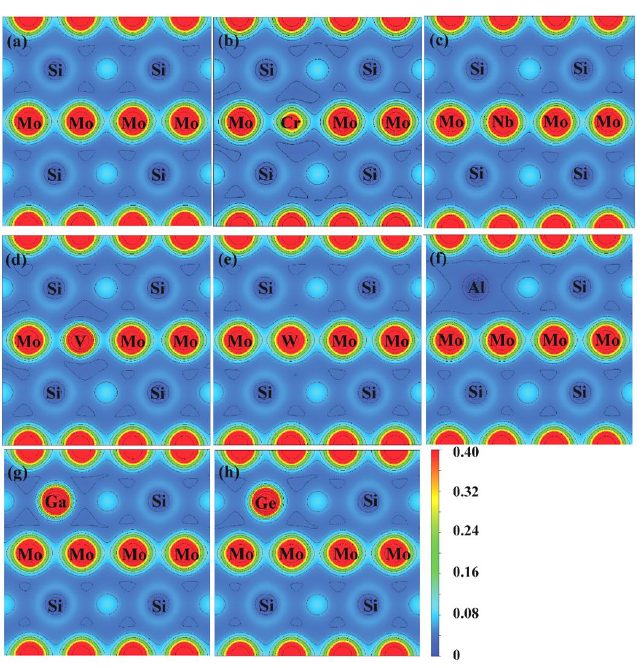
Figure 8. Charge densities of undoped and doped Mo 3 Si. ( a ) undoped; ( b ) Cr; ( c ) Nb; ( d ) V; ( e ) W; ( f ) Al; ( g ) Ga; ( h ) Ge.